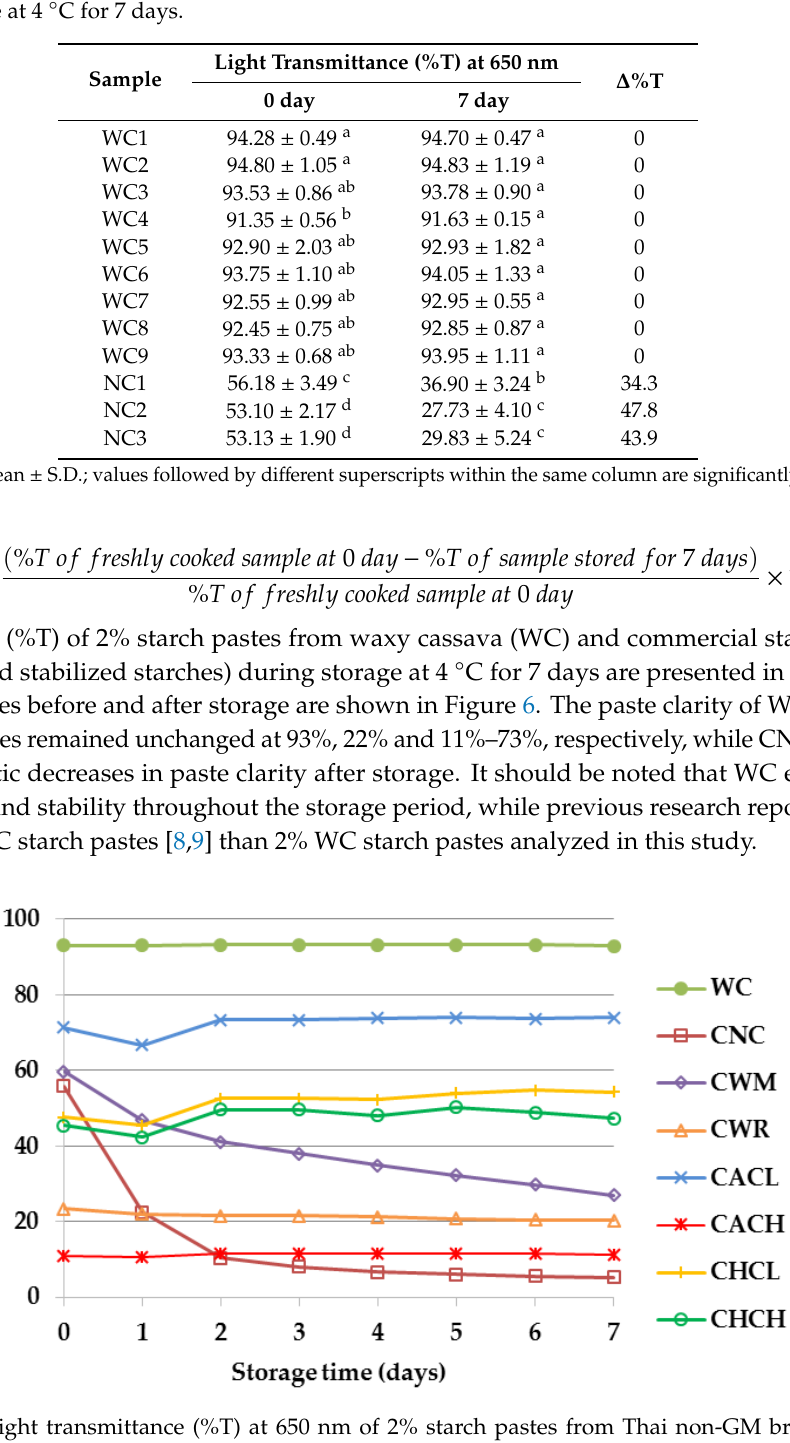
Figure 5. Light transmittance (%T) at 650 nm of 2% starch pastes from Thai non-GM bred waxy cassava starch (WC), commercial normal cassava starch (CNC), commercial waxy maize starch (CWM), commercial waxy rice starch (CWR) and commercial acetylated cassava starches with low and high degrees of substitutions (CACL and CACH) and commercial hydroxypropylated cassava starches with low and high degrees of molar substitutions (CHCL and CHCH) during storage at 4 °C for 7